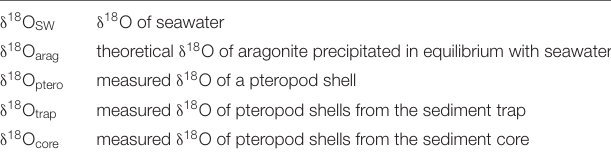
= 0.742, R 2 = 0.006; δ 13 C core : p core : p